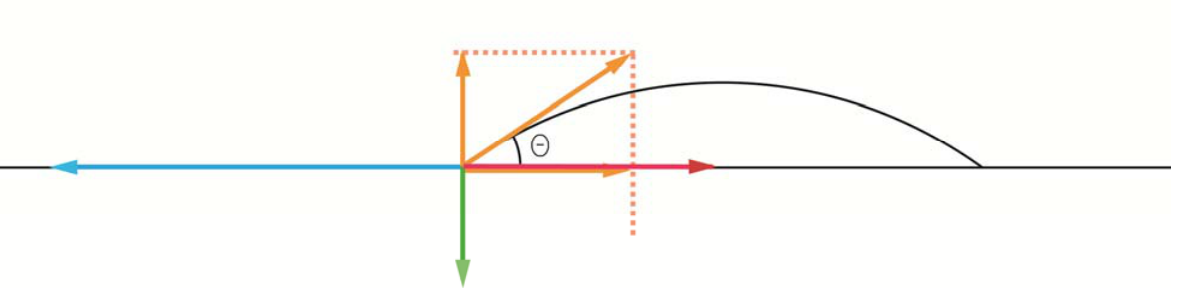
Figure 6. Force components at a gas-solid-liquid triple point. The blue arrow represents surface tension, the red arrow the σ , and the hypotenuse of the yellow arrows the the σ SG SL σ . By knowing the contact angle of the liquid, the σ vector can be split into a force LG LG parallel to the solid surface ( σ cos θ ) and one perpendicular to the surface ( σ sin θ ). In LG LG order to generate a force balance in vertical direction, the green force vector was introduced, for which the magnitude then becomes σ sin θ . By balancing the horizontal LG forces, σ = σ + σ cos θ , the expression can be rewritten as cos θ = ( σ – σ )/ σ SG SL LG SG SL LG